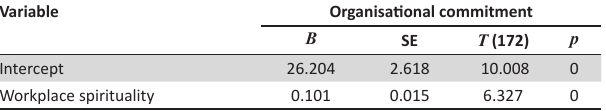
TABLE 5: Regression analysis for workplace spirituality and organisational commitment.